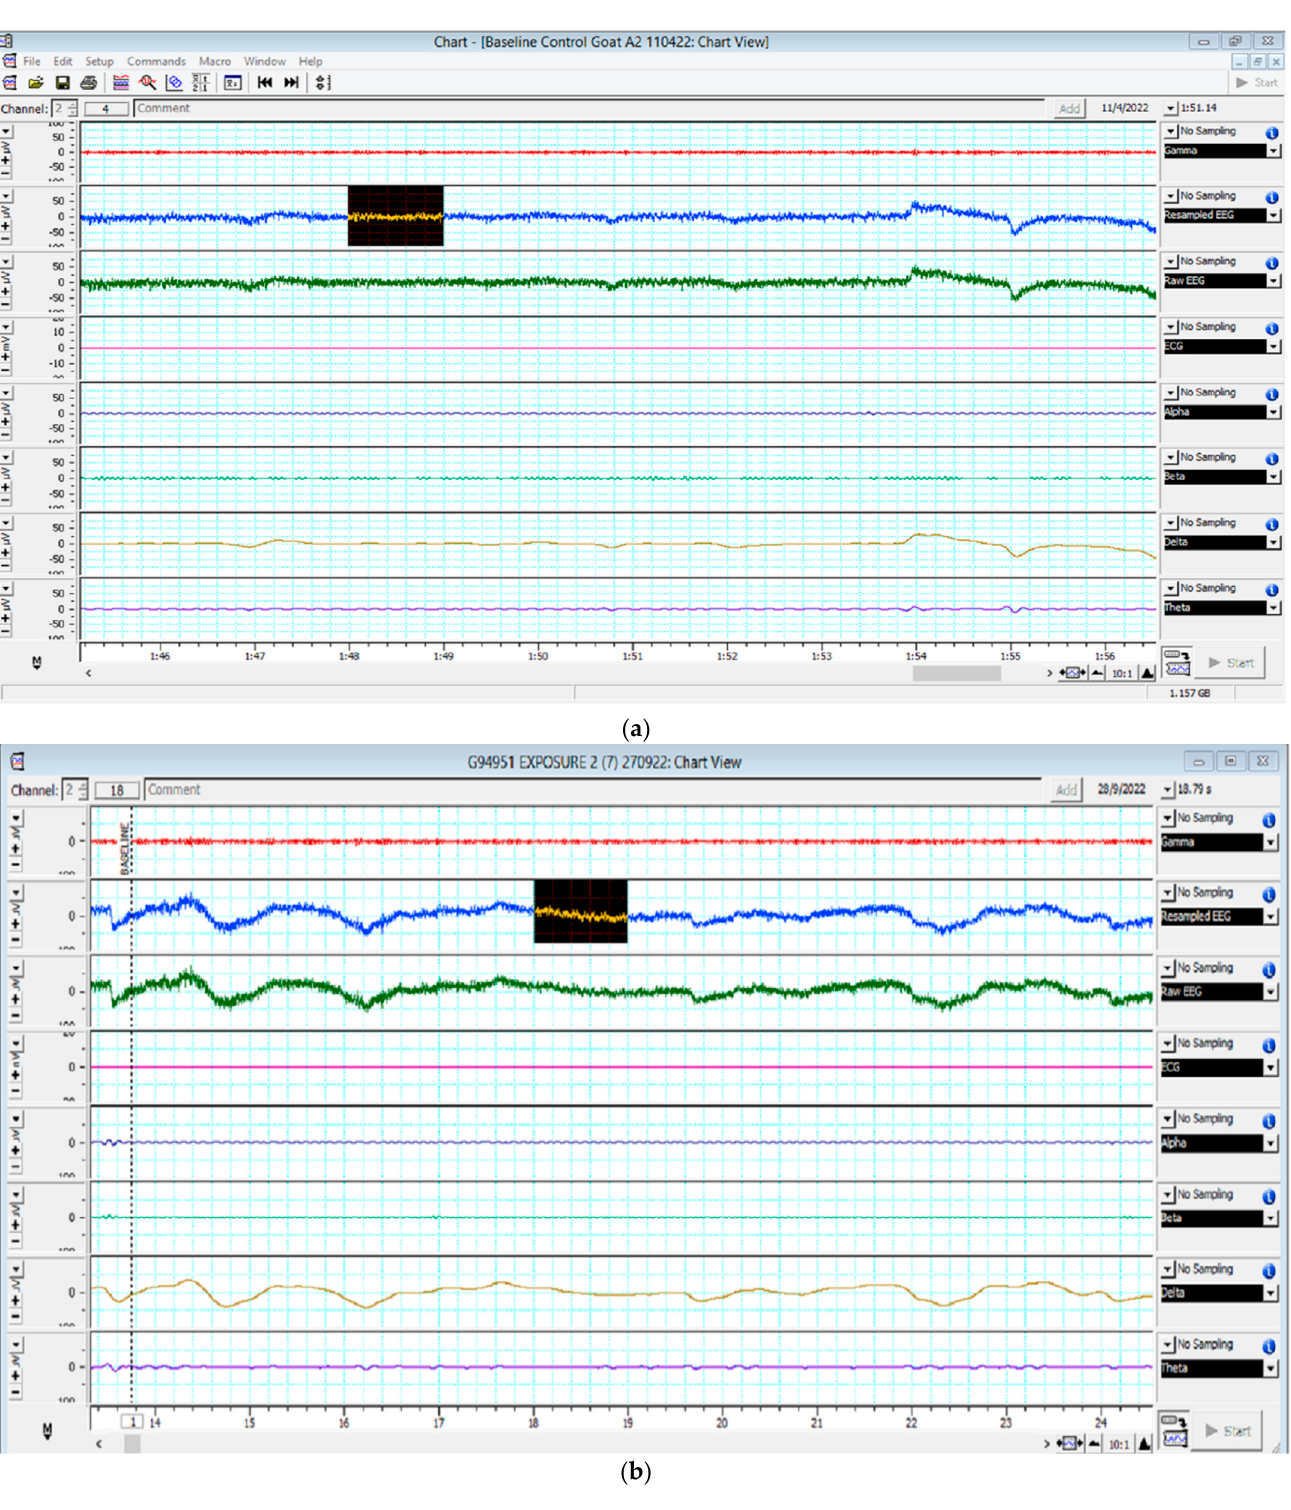
Figure 3. ( a ): EEG power spectrum during control state. ( b ): EEG power spectrum during treat ‐ ment state. ment